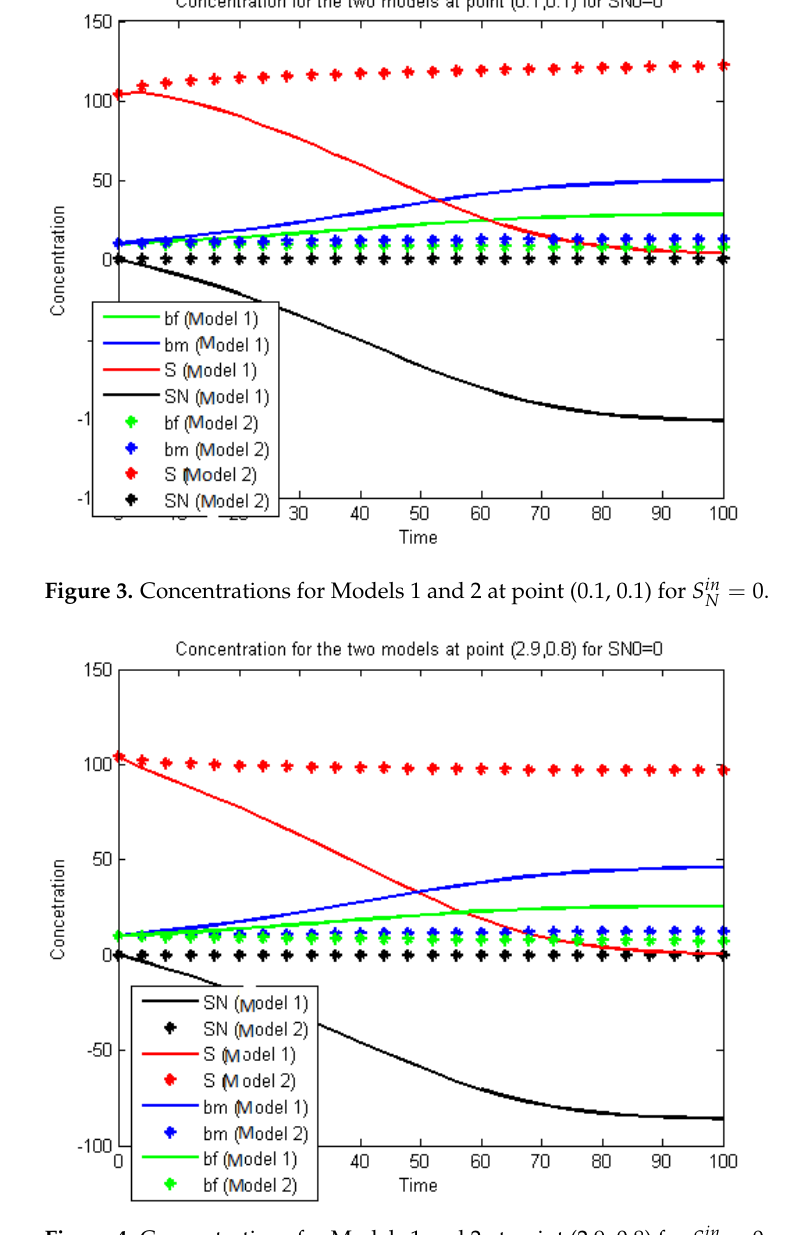
Figure 4. Concentrations for Models 1 and 2 at point (2.9, 0.8) for S in